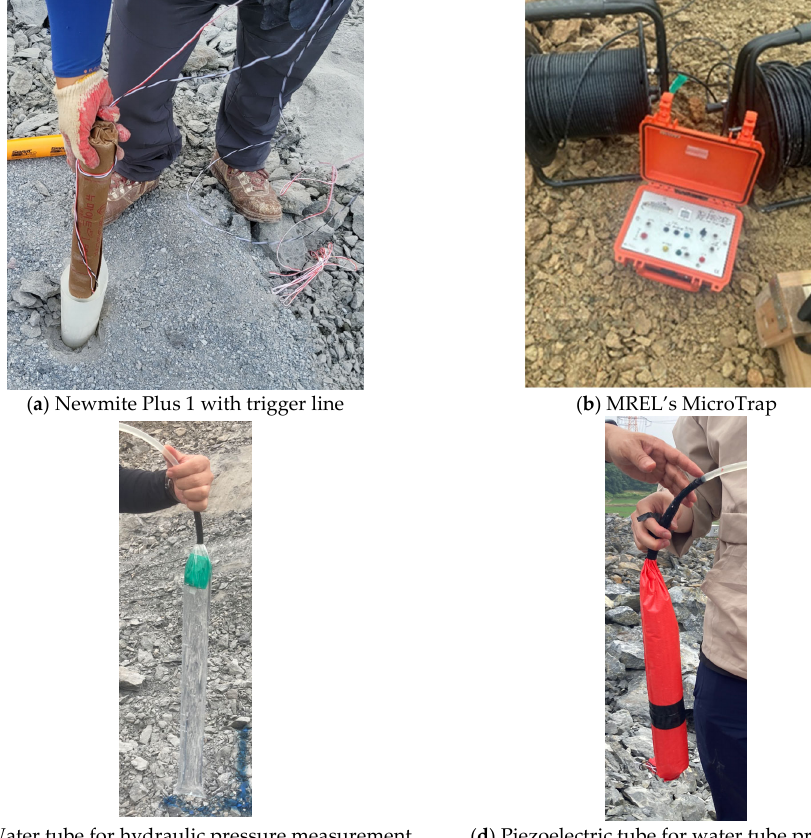
Figure 7. Measuring tool applied to blast pressure measuring system.